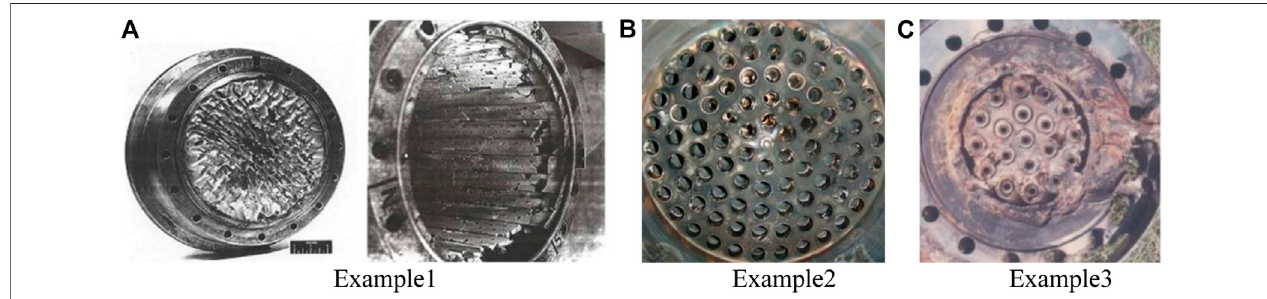
FIGURE 1 | Three damaged LREs caused by HFCI. (A) Example1. (B) Example2. (C)